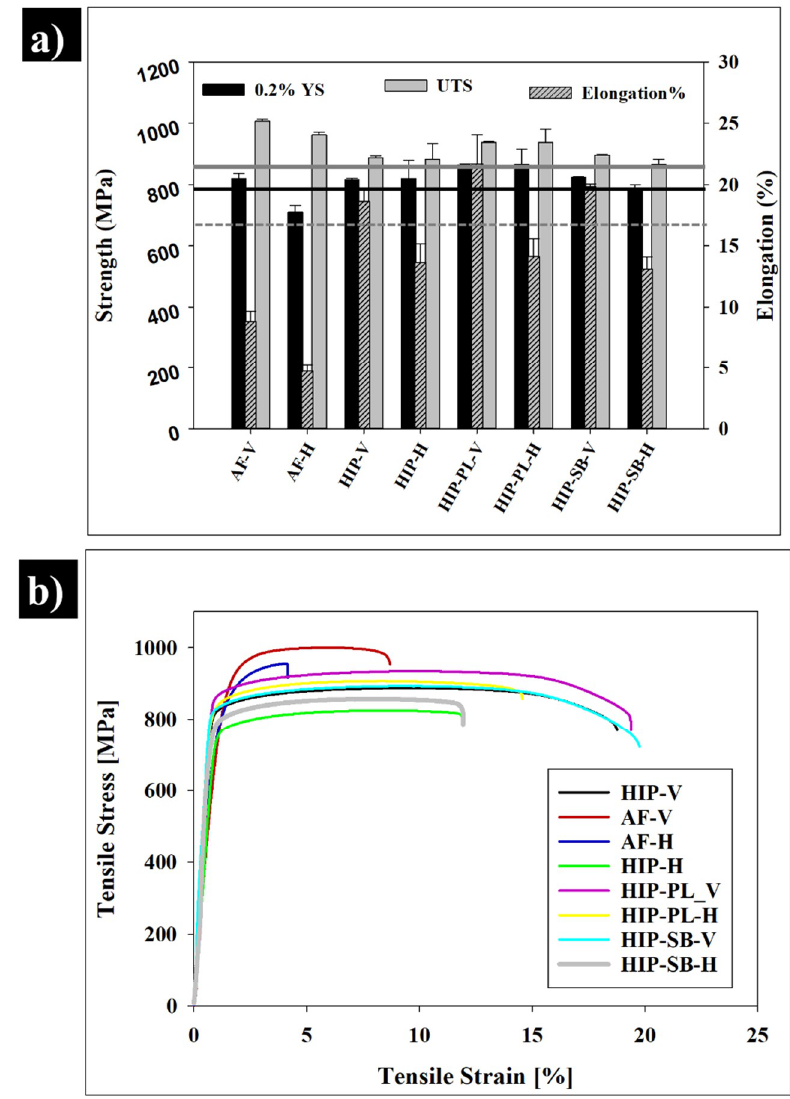
Figure 6. ( a ) Effect of post‐processing on the tensile properties of SLMed Ti‐6Al‐4V. As‐fabricated Figure 6. ( a ) E ff ect of post-processing on the tensile properties of SLMed Ti-6Al-4V. As-fabricated (AF), vertical orientation (V), horizontal orientation (H), hot‐isostatic‐pressed samples (HIP), polished (AF), vertical orientation (V), horizontal orientation (H), hot-isostatic-pressed samples (HIP), polished samples (PL), and sandblasted samples (SB). ( b ) Typical tensile stress‐strain curves for the as‐ samples (PL), and sandblasted samples (SB). ( b ) Typical tensile stress-strain curves for the as-fabricated fabricated condition and in various post‐processing conditions. condition and in various post-processing